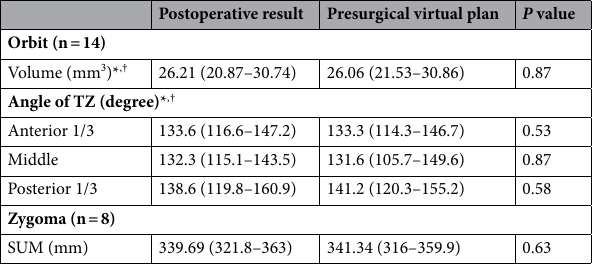
Table 3. Comparison of postoperative result and presurgical virtual plan. SUM sum of Z1O to Z5O or P1O to P5O; *Mean, † Range.